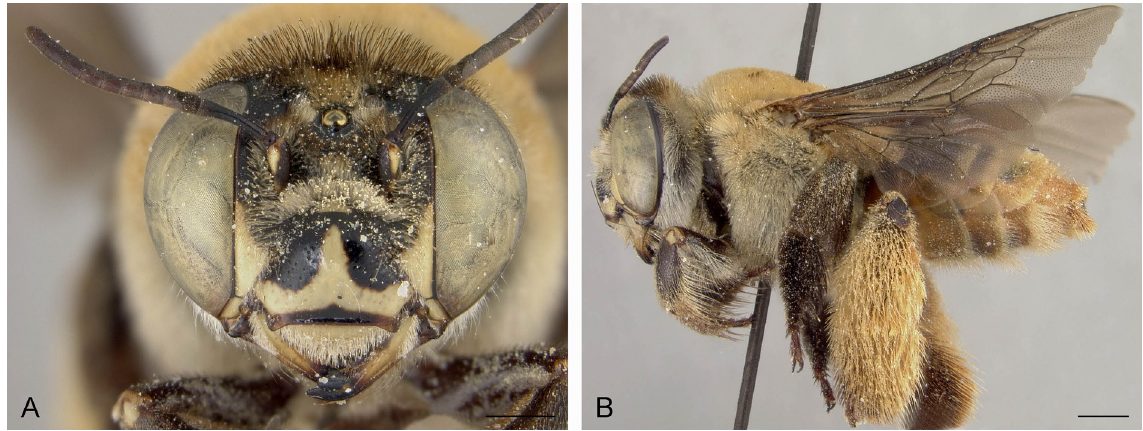
Fig. 2. Centris adani Cockerell, 1949, holotype, ♀ (NMNH; USNM ENT 00534186). A . Frontal view. B . Habitus, lateral view. Scale bars: A = 1 mm; B = 2